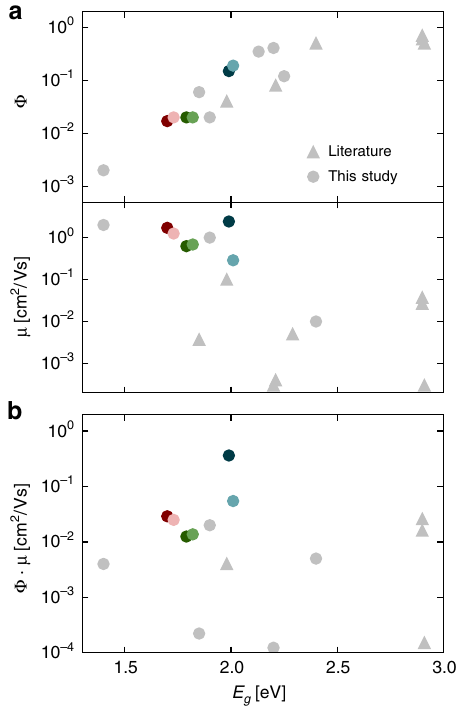
Fig. 1 Relationship between mobility and luminescence in conjugated polymers. a Quantum yield Φ and charge carrier mobility μ (extracted from FET measurements) against bandgap energy E g ; b Product Φ · μ parametrised in terms of the E g of different materials: literature (triangles) and this study